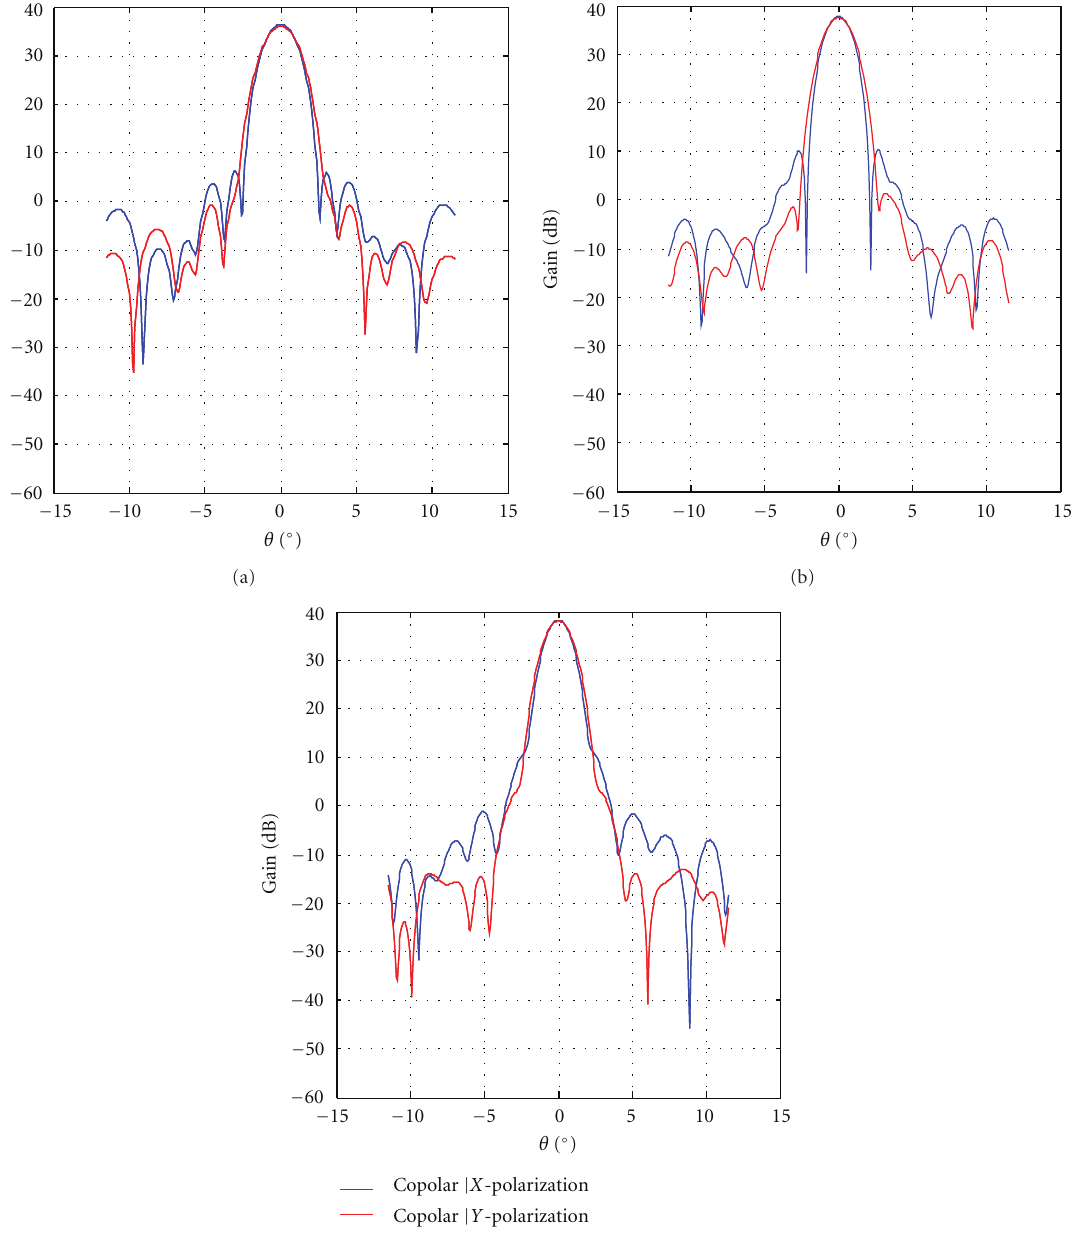
Figure 6: Azimuth cut of radiation pattern for X -polarisation at 10.7 GHz (a), 12.75 GHz (b), and 14.25 GHz (c) when using the required phase distribution on the main